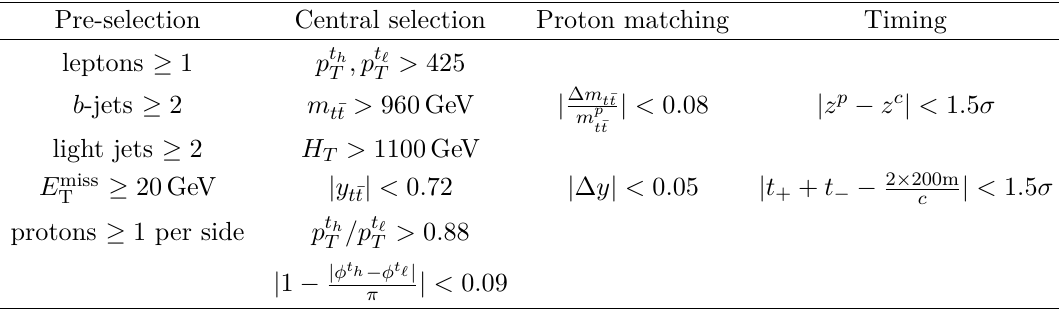
Table 1. Summary of the analysis sequential cuts applied at each selection